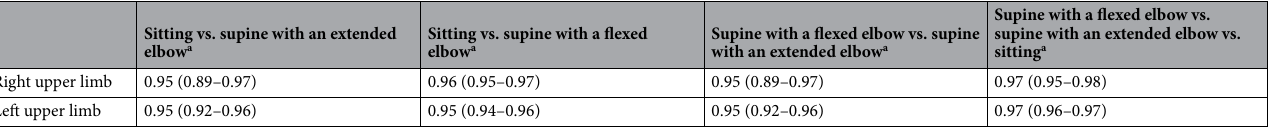
Table 2. Reproducibility test, the reassessment of prehensile strength in three positions. a Data presented as an intraclass correlation coefficient (lower limit and upper limit of the confidence